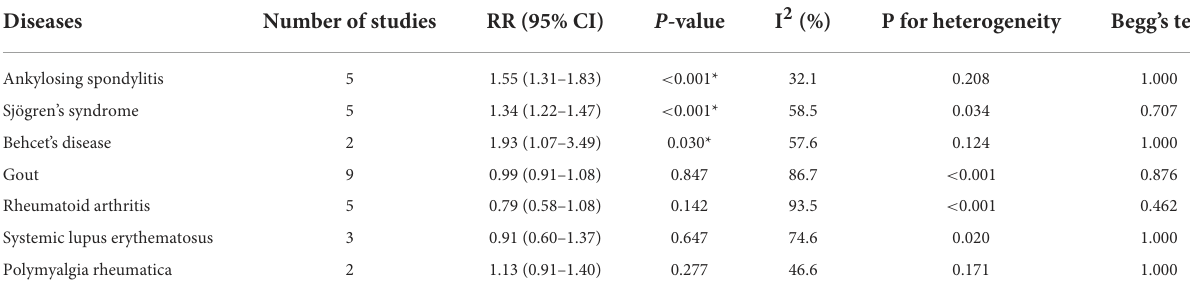
TABLE 2 Overall meta-analysis results on associations between different types of inflammatory rheumatic diseases and PD risk. Diseases